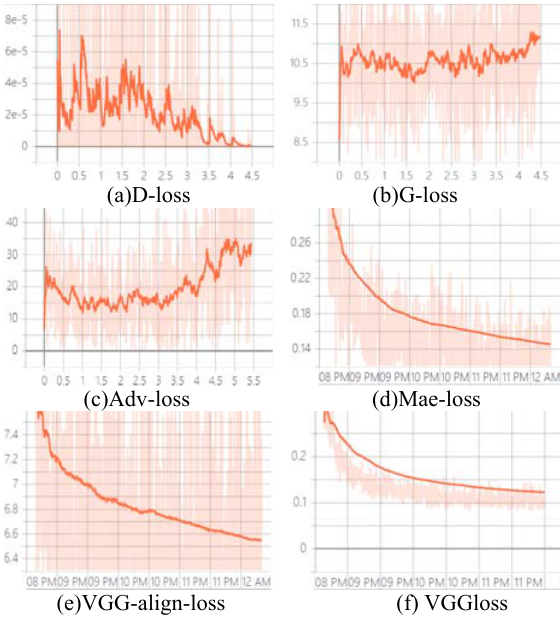
Figure 7 . Linear feature repair model loss function